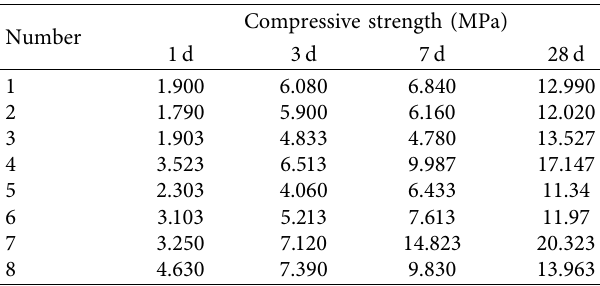
Table 6: The compressive strength of concrete specimens at various ages.